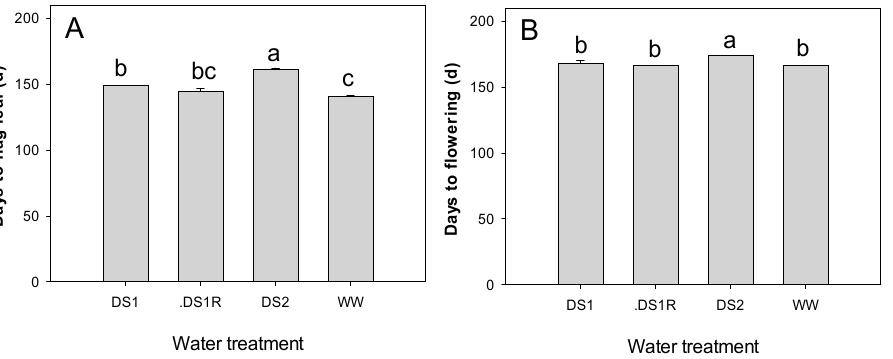
Figure 3. Days to flag leaf ( A ) and flowering ( B ) compared among the water treatments. Among water treatments, the traits mean with different letters are statistically different ( p < 0.05).